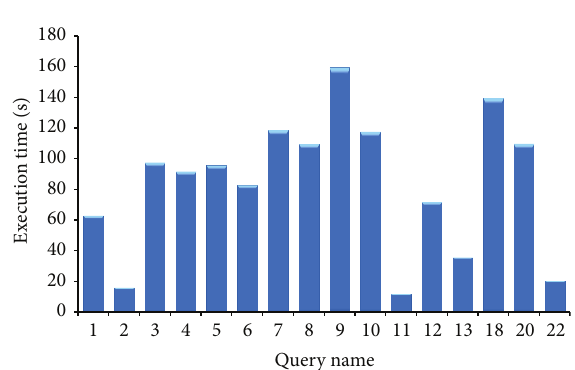
Figure 10: Response time of sample queries with the highest performance configuration VM settings and network bandwidths.